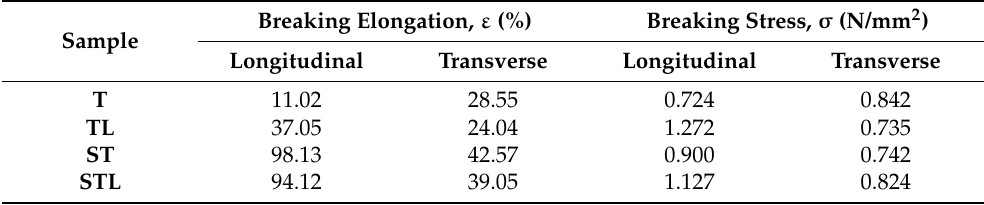
Table 4. Breaking stress and elongation of the analyzed